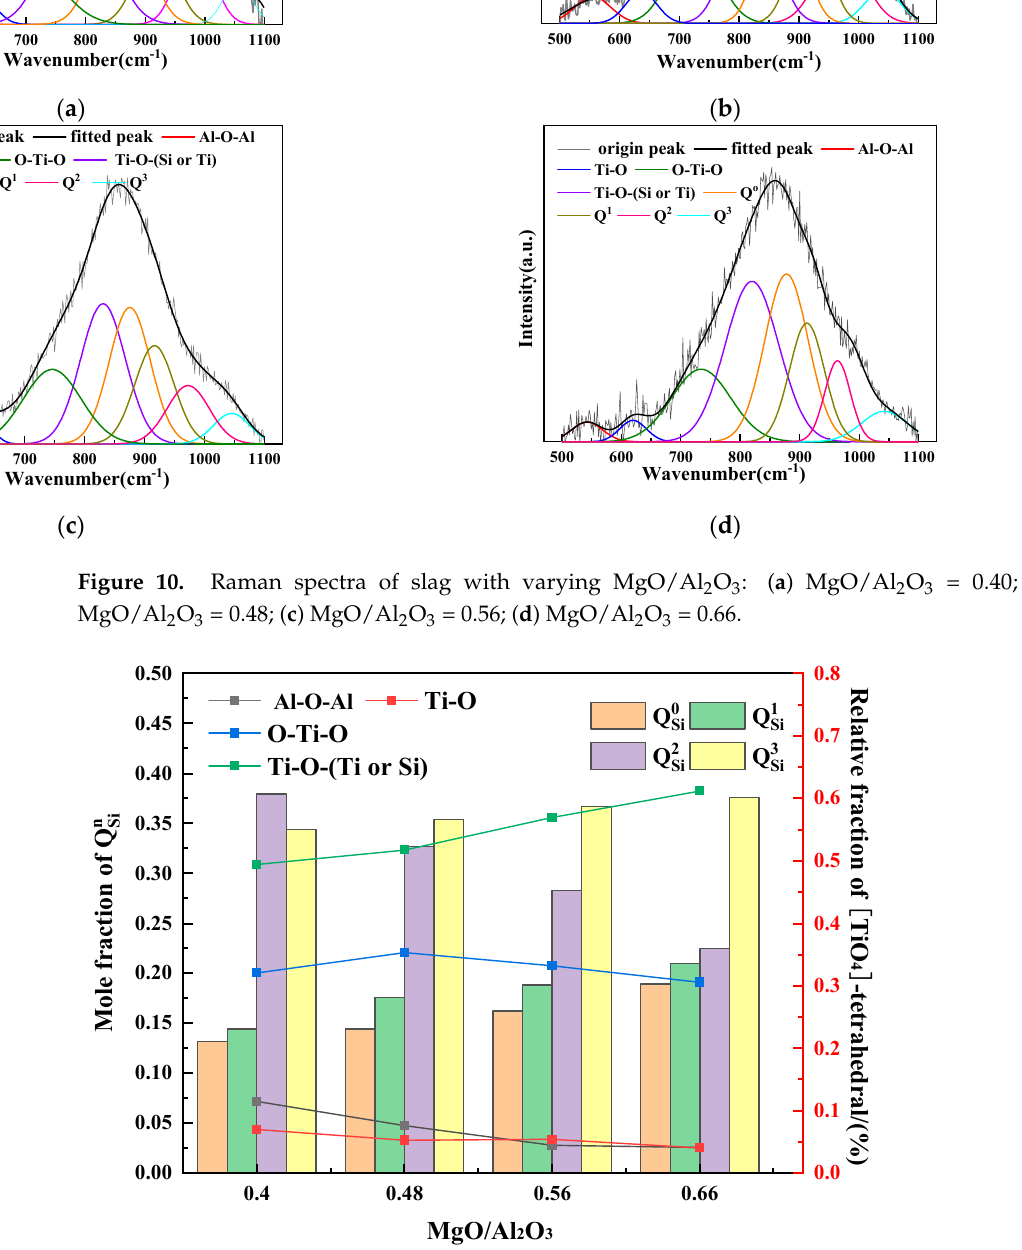
Figure 11. Relative area fractions of each band of chlorine-containing high-titanium slag.